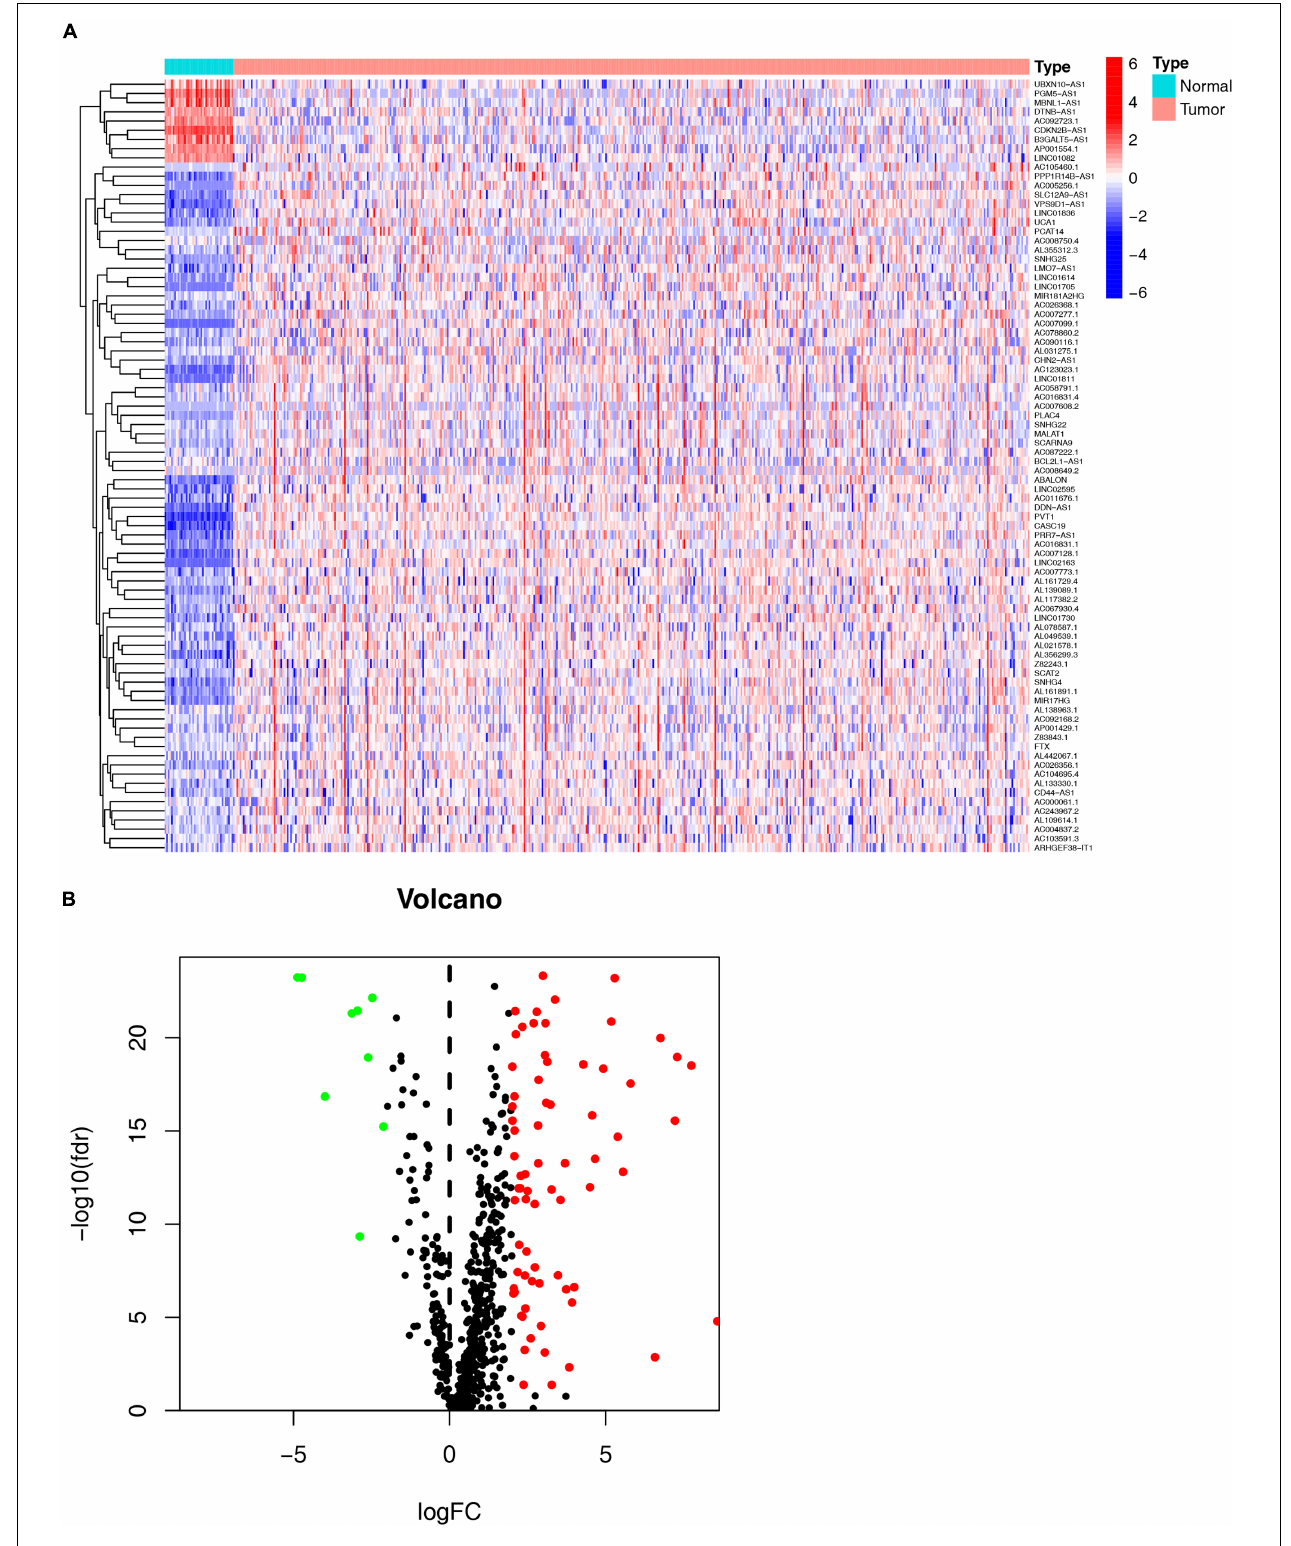
FIGURE 2 | Identification of differential expression immune-related lncRNAs (DE immune-related lncRNAs). The heatmap (A) and volcano plot (B) show DE immune-related lncRNAs (DEirlncRNAs) between the colorectal cancer tumor samples and the normal samples.